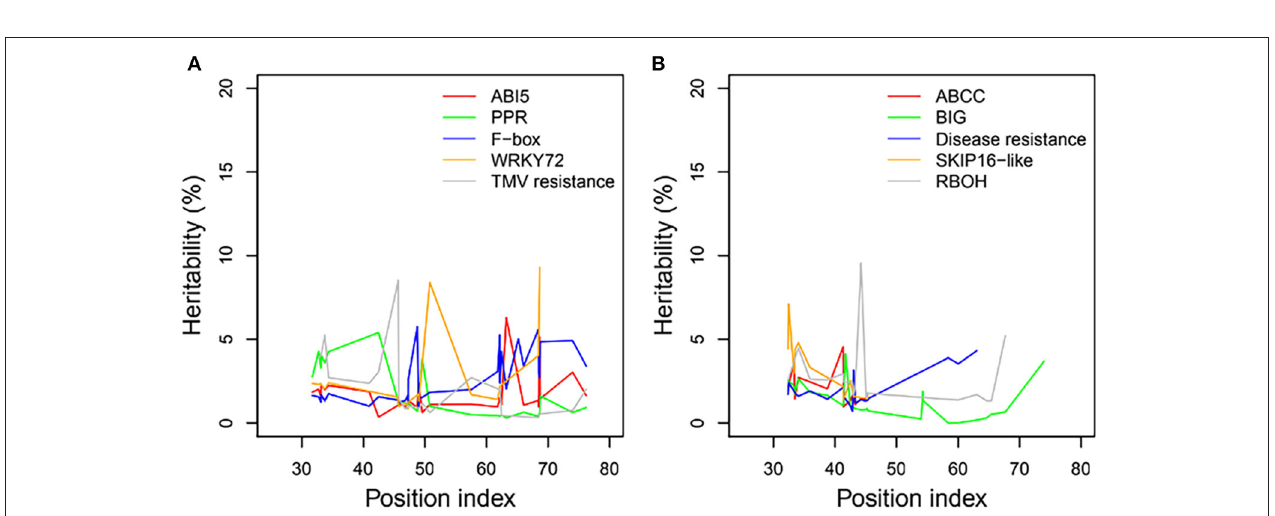
FIGURE 8 | Heritabilities of significant genes regulating heterophylly for control and salt stress condition. (A,B) List the heritabilities of five different genes with different position index,